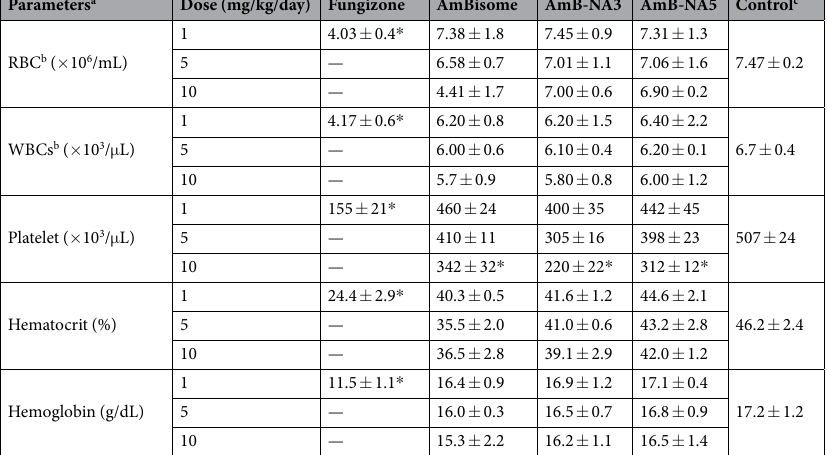
Table 4. Hematological parameters on post-injection effects at day 8 after seven doses (1, 5, and 10 mg/kg/day of AmB). The commercial formulation of Amphotericin B, Fungizone was given at dose of 1 mg/kg for 7 days. a All parameters were expressed as mean values ± SD. b RBC, red blood cells; WBC, white blood cells. c Control groups received only PBS. * Significant at P < 0.05, Students t